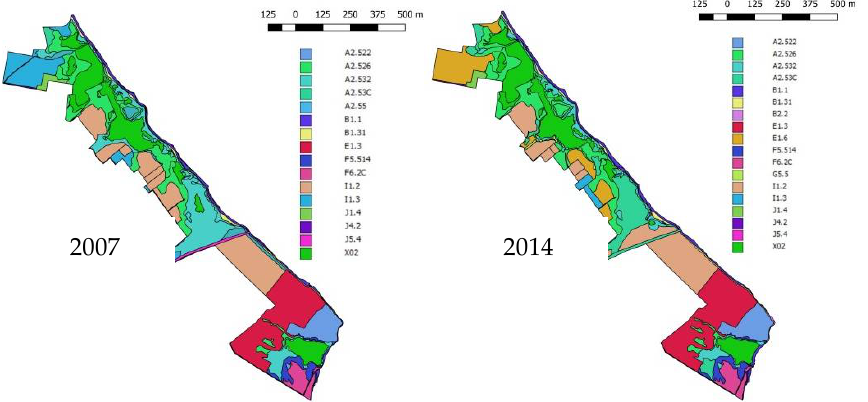
Figure 2. European Nature Information System (EUNIS) map of the Saline di Punta della Contessa (SC) site in 2007 and in 2014.